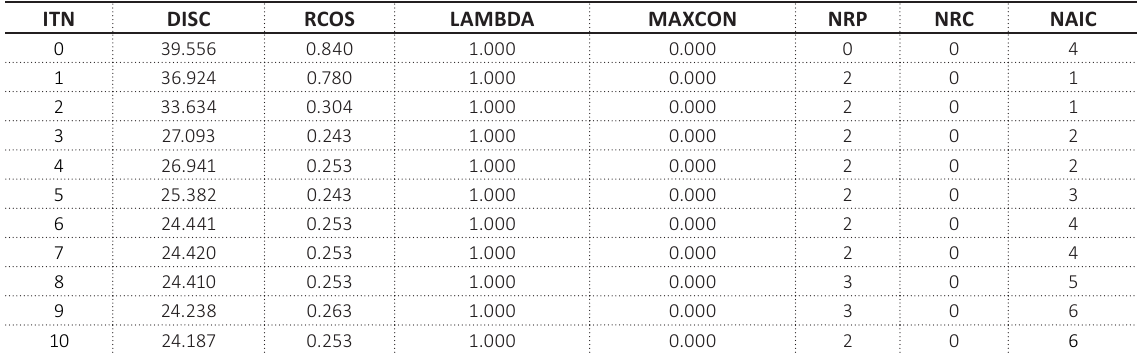
Table 5. Results of the optimal solution search (a fragment for Slovenia) ITN